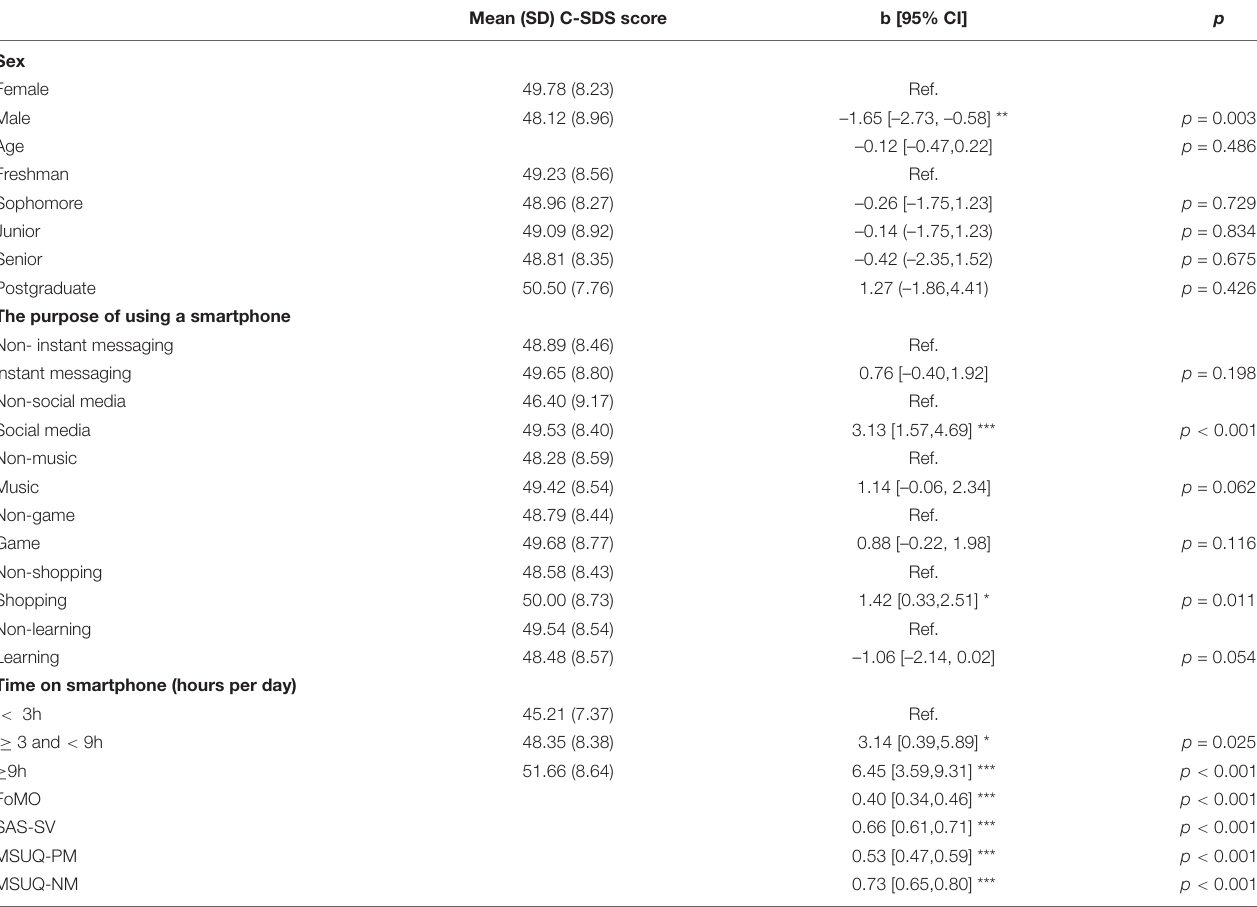
TABLE 5 | Associations of variables with C-SDS score ( n =